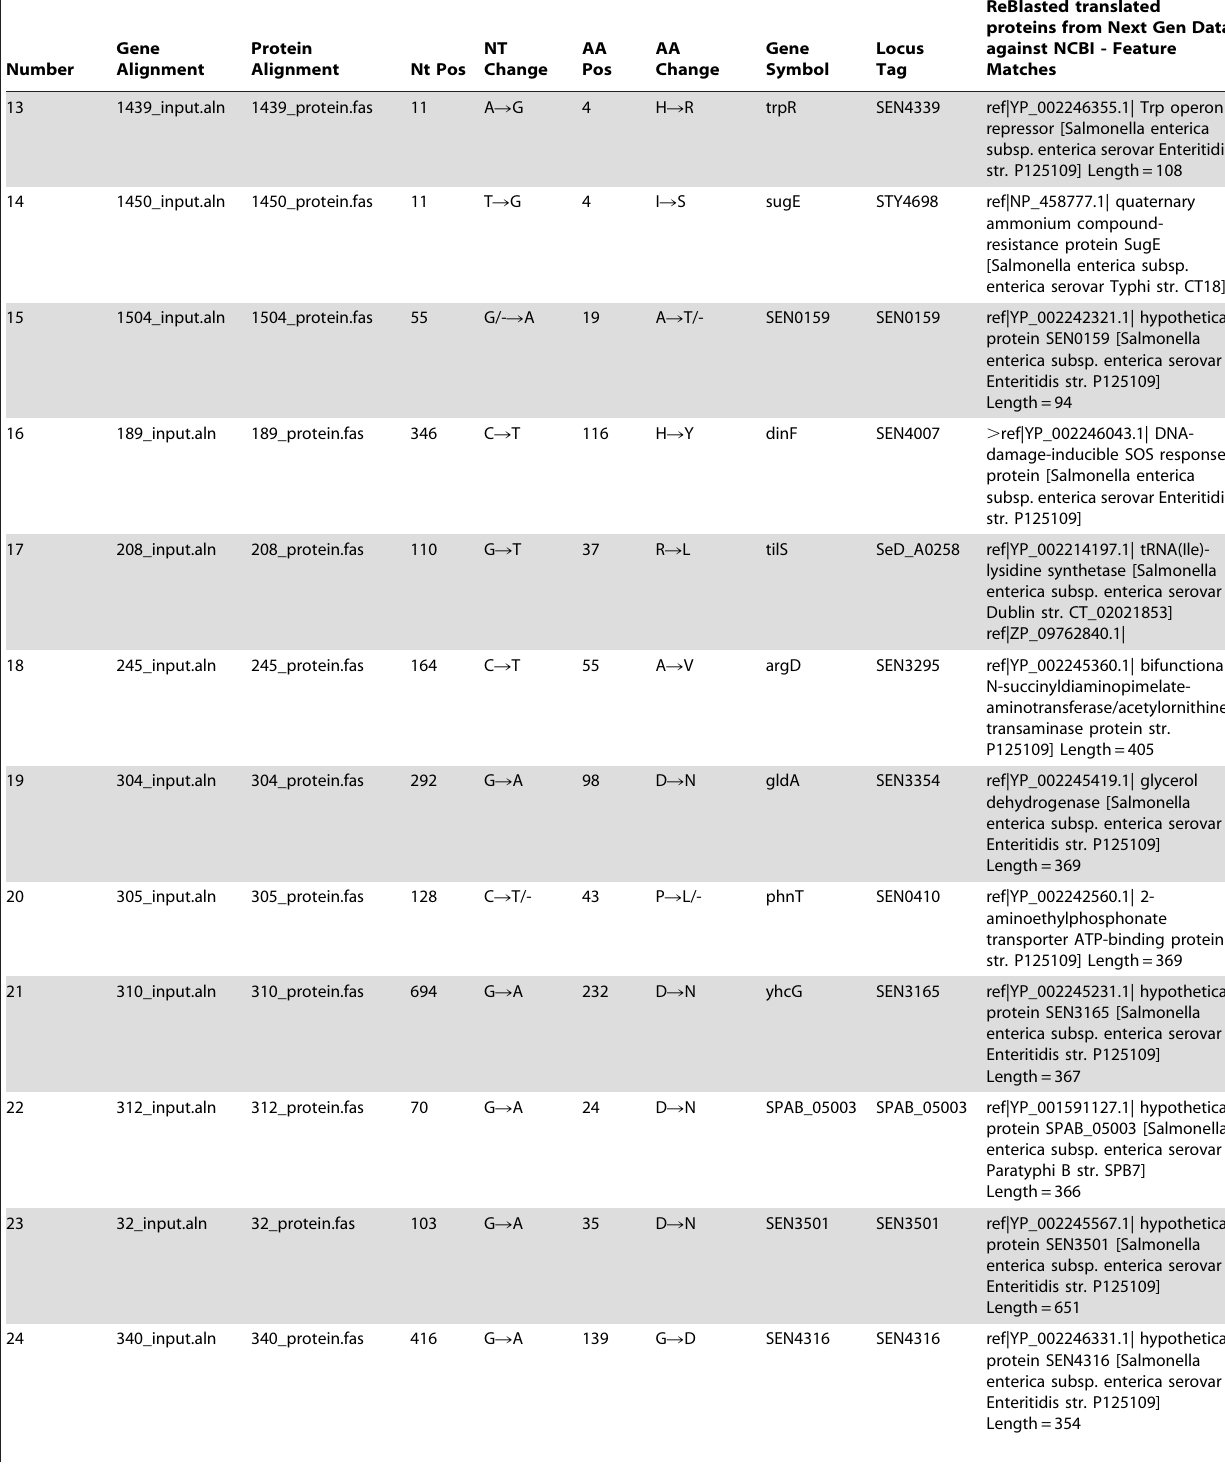
Variable genes observed that may define Salmonella